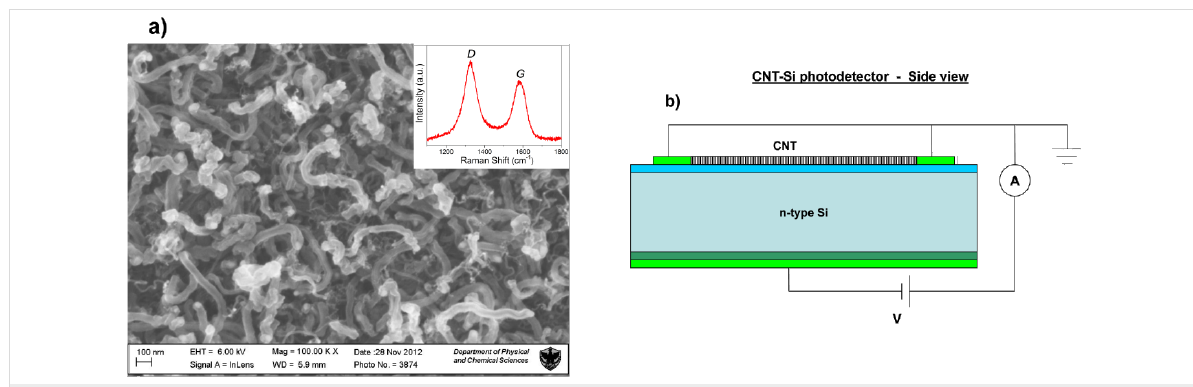
Figure 2: (a) Scanning electron microscopy (SEM) image of MWCNT samples grown on the implantation area. The inset shows a Raman spectrum of the same sample (b) Side view of electrical readout connections.